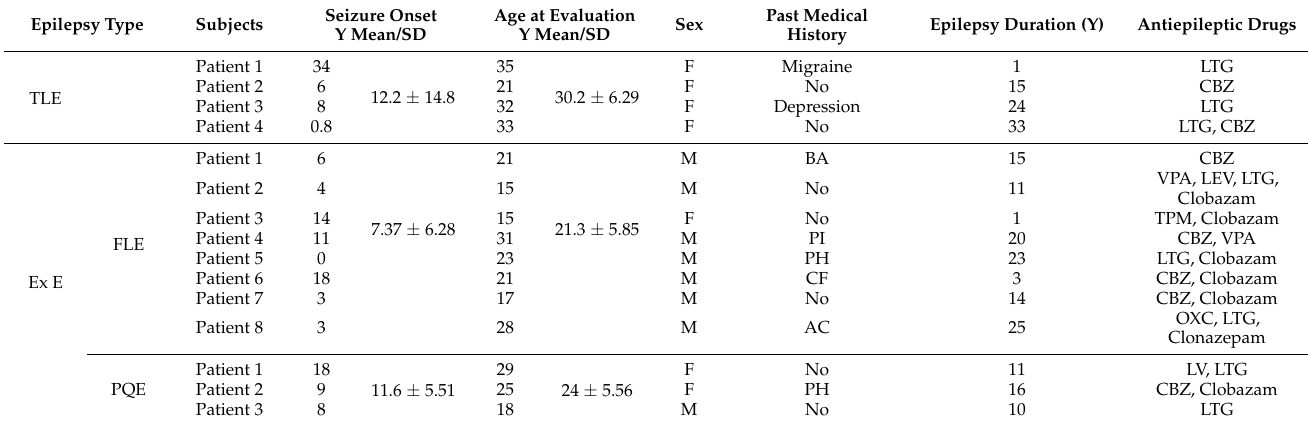
Table 1. Demographic and clinical